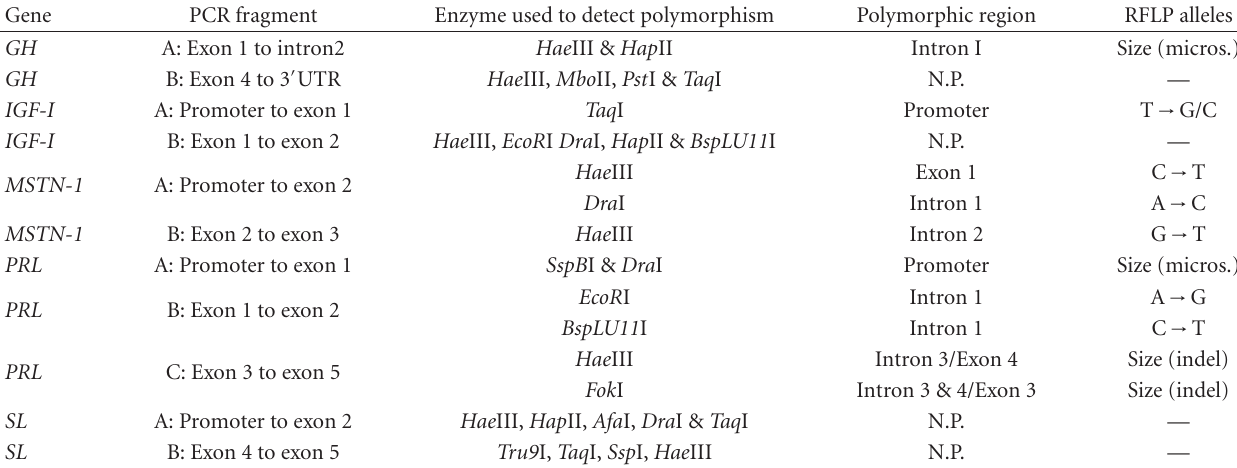
Table 1: Description of RFLPs in five candidate genes related to growth traits in gilthead seabream analyzed in this work. Gene PCR fragment Polymorphic region